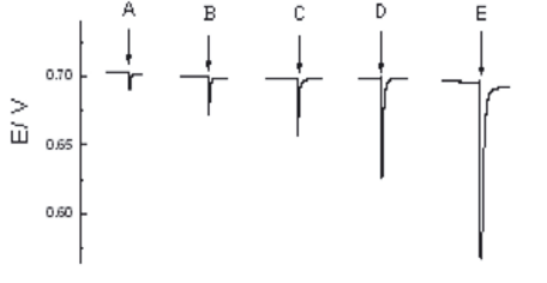
Figure 5. The perturbation of p- nitroaniline on the non-equilibrium stationary state in B-Z oscillating system. Conditions: [ p- nitroaniline]: (A)=3.75 × 10 -7 mol L -1 ; (B)=3.75 × 10 -6 mol L -1 ; (C)=3.75 × 10 -5 mol L -1 ; (D)=1.00 × 10 -4 mol L -1 ; (E)=5.00 × 10 -3 mol L -1 . Common conditions: [MnSO [KBrO